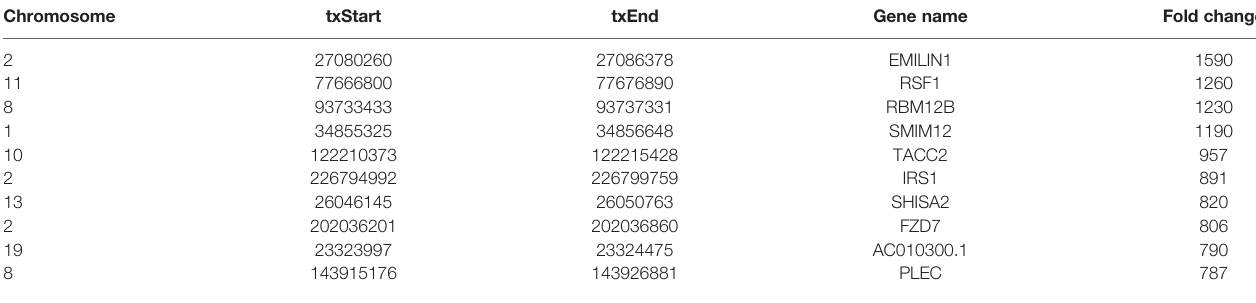
TABLE 2 | The top 10 hypomethylated m6A-modi fi ed peaks for bladder cancer tissues compared to normal tissues. Chromosome